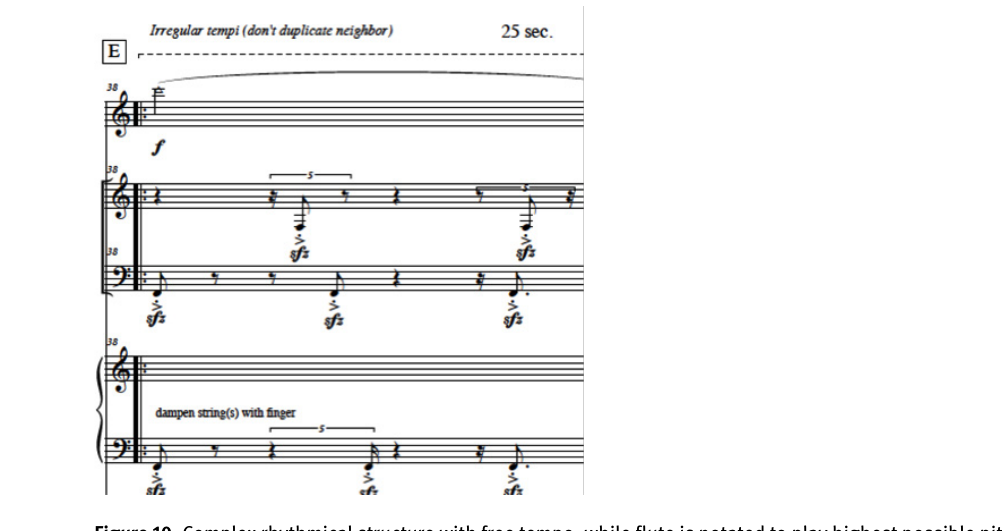
Figure 10. Complex rhythmical structure with free tempo, while flute is notated to play highest possible pitch with upwards arrow symbol.